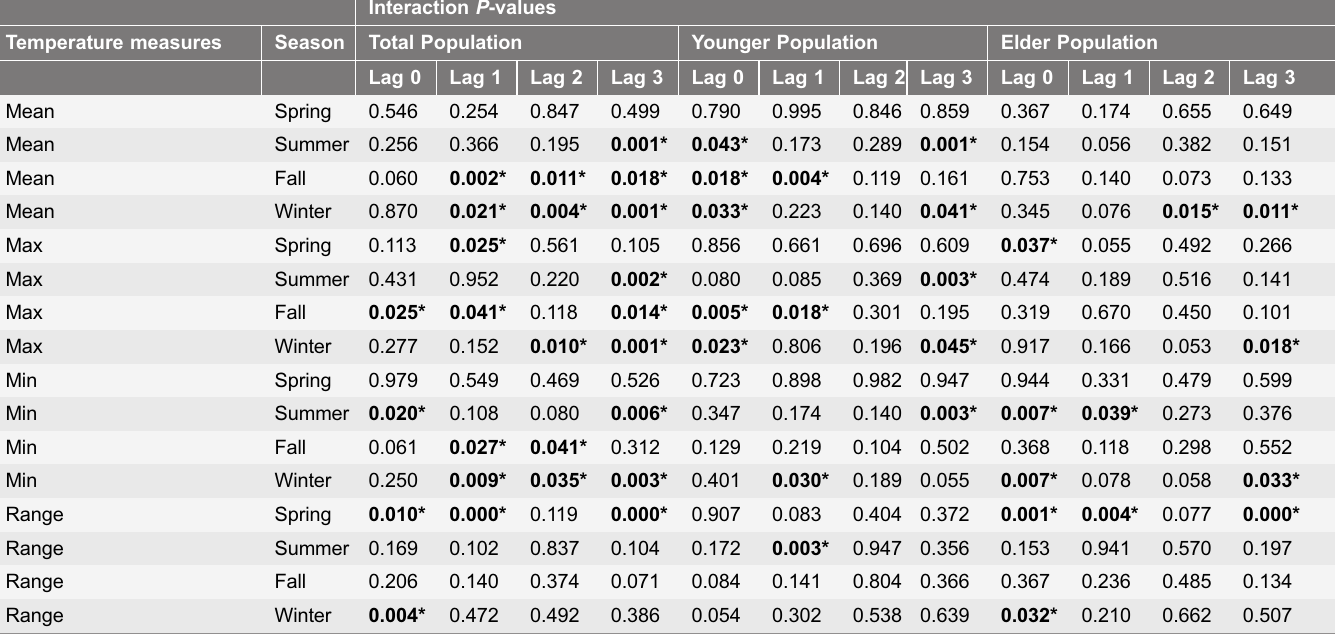
Table 1. Month by temperature interaction by 4 seasons in the total, younger and elder population adjusted for O 3a . Interaction P